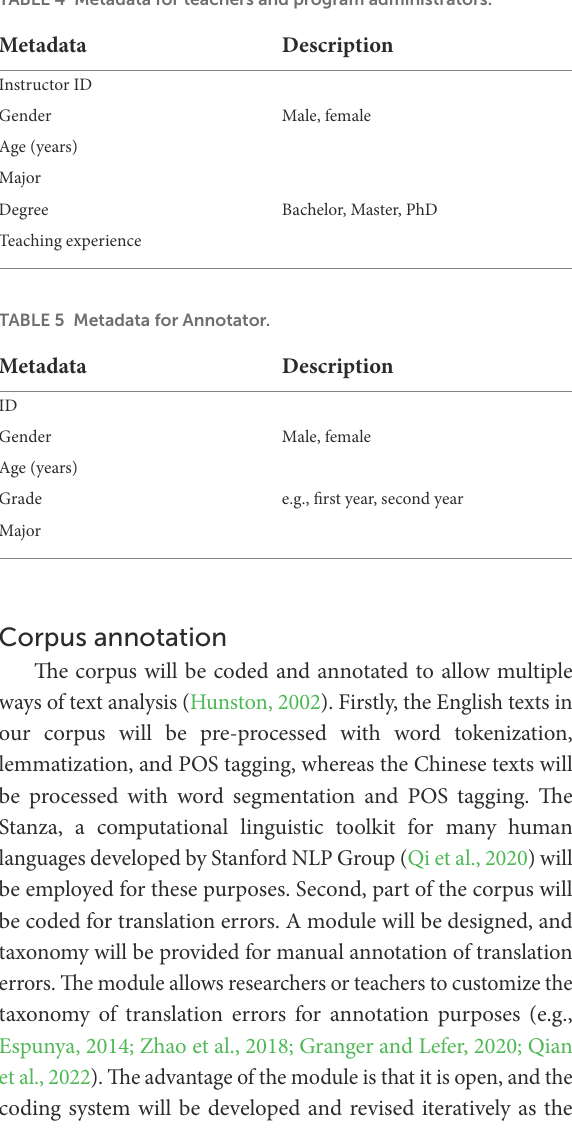
TABLE 4 Metadata for teachers and program administrators.